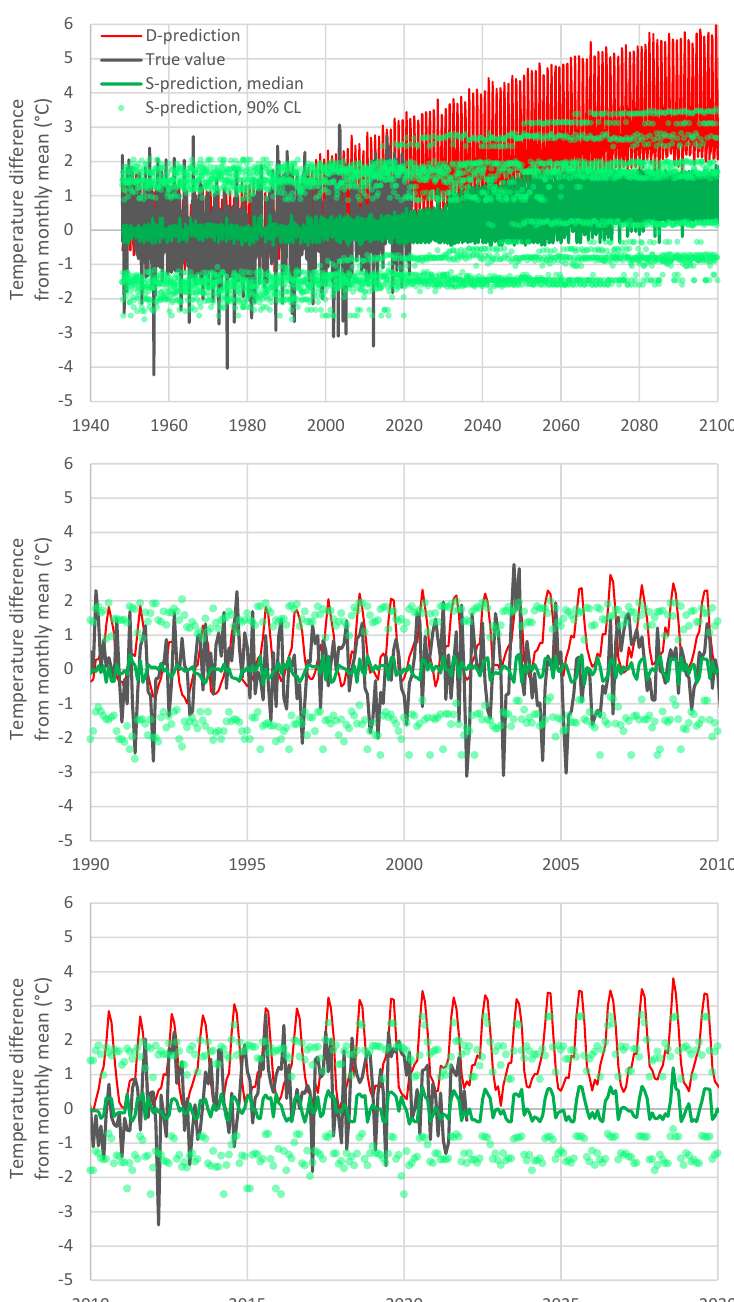
Figure 5. True values and predictions by D-model and S-model (median and 90% confidence limits) of temperature in Italy: ( upper ) entire period; ( middle and lower ) focus on 20-year periods.